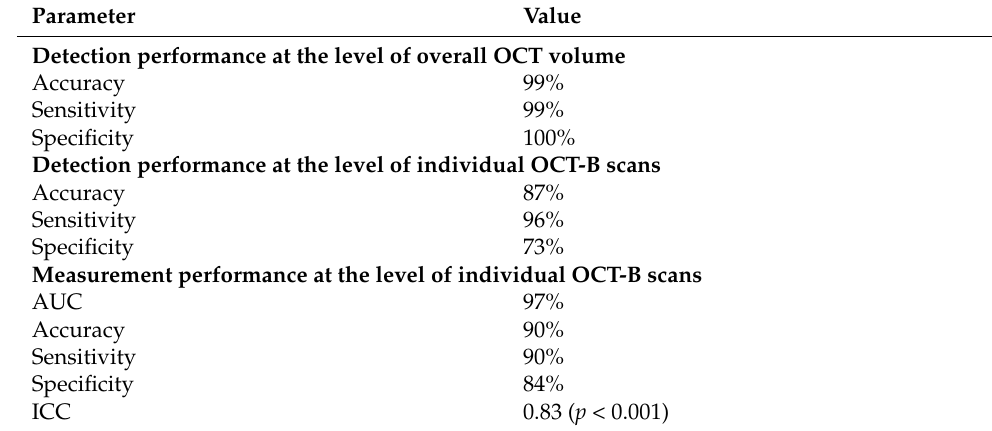
Figure 4. ROC illustration of the DL-based EZ At-Risk segmentation model at the individual SD- OCT B-scan level with accuracy, sensitivity, and specificity. ROC: receiver operator curve; DL: deep learning: EZ: ellipsoid zone; SD-OCT: spectral domain optical coherence tomography. Table 1. Summary of DL-based results for detection and measurement of EZ At-Risk . DL: deep learning; EZ: ellipsoid